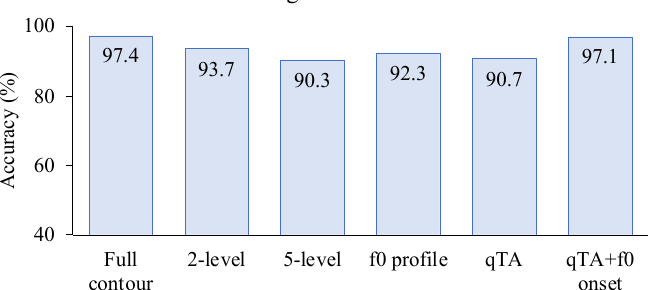
Figure 5. Summary of tone recognition rates based on SVM model for full f 0 contour (Experiment 1), two-level feature (Experiment 2), five-level feature (Experiment 3), f 0 profile (Experiment 4) and qTA and qTA + f 0 onset (Experiments 5). SVM: Support Vector Machine.